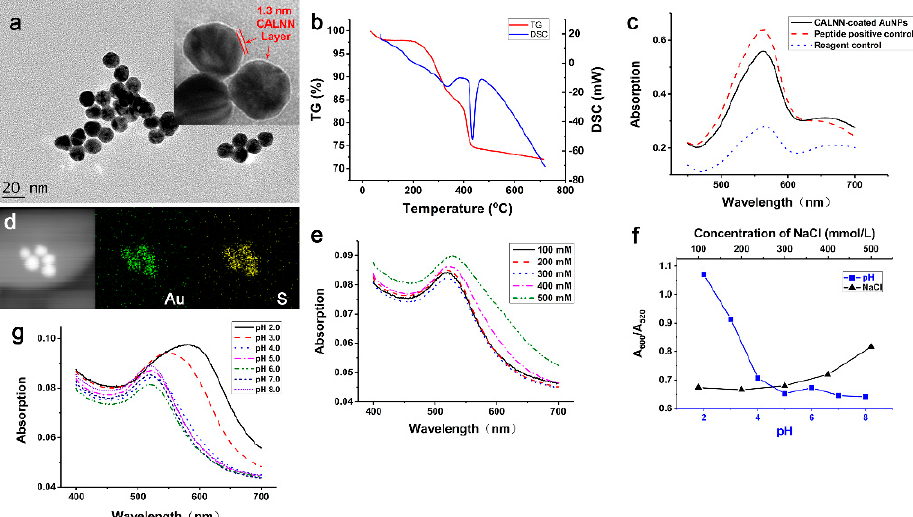
Figure 4. ( a ) TEM image of CALNN-coated AuNPs prepared under optimized conditions.